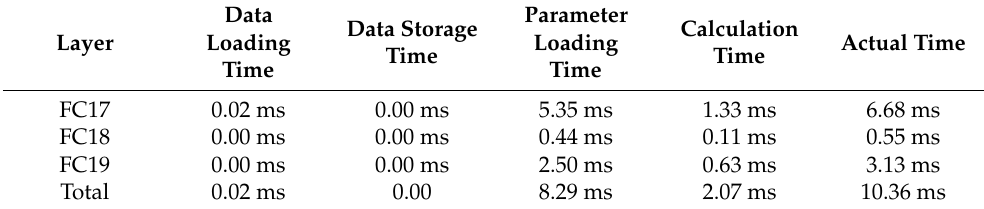
Table 6. Calculation time for fully connected